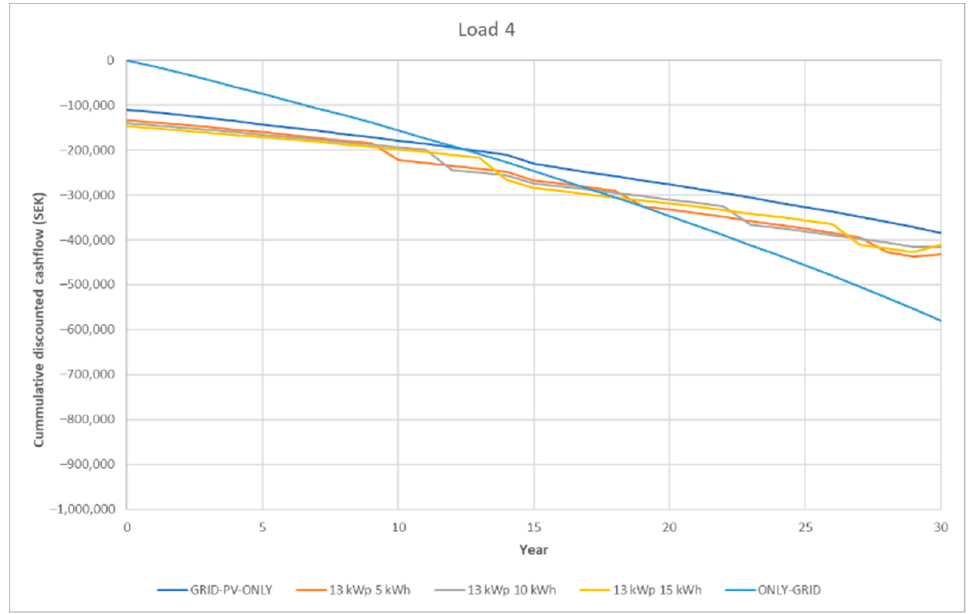
Figure 6. Cumulative cash flow for four load profiles with tariffs of utility 2.